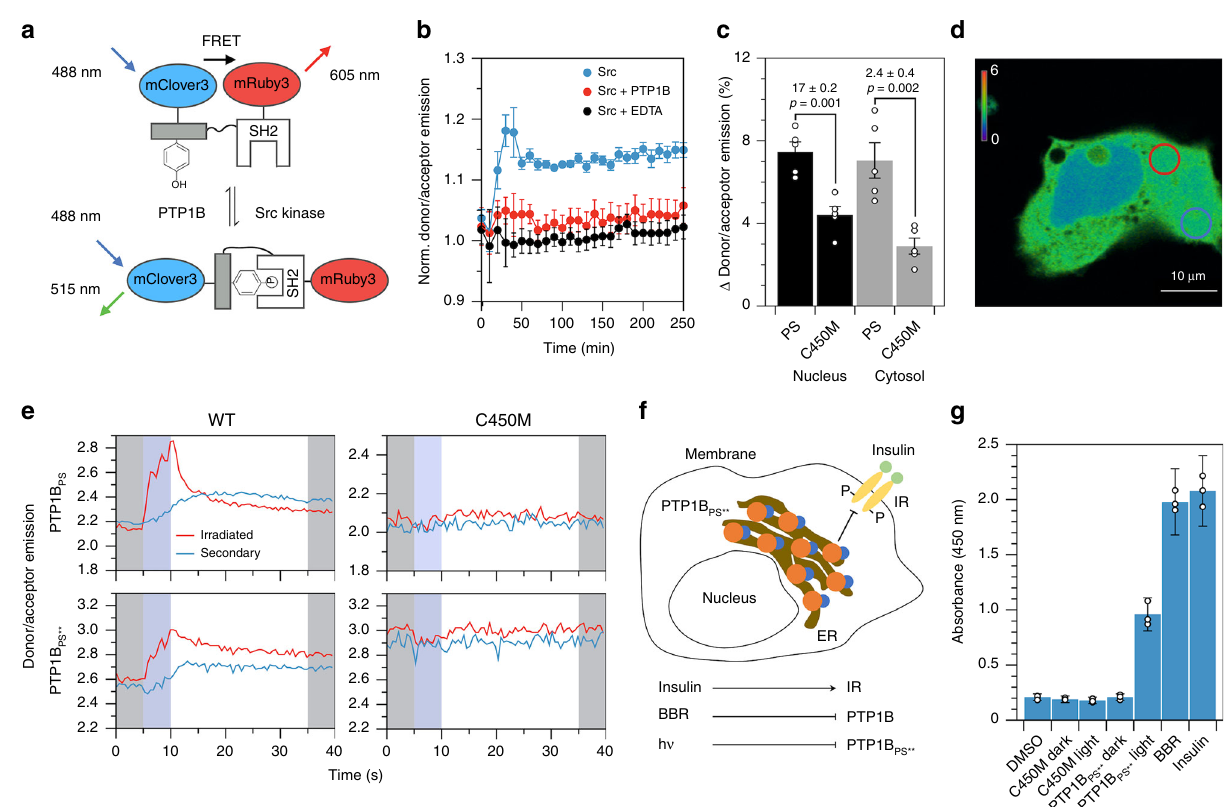
Fig. 4 Localized deactivation of PTP1B PS . a A biosensor for PTP1B activity. Src-mediated phosphorylation of the substrate domain causes it to bind to the SH2 domain, triggering a conformational change that decreases FRET; dephosphorylation by PTP1B increases FRET. b Src increases the donor/acceptor emission ratio in vitro (normalized by the buffer-only condition); EDTA or PTP1B prevent this increase. Error bars denote propagated SE for measurements of n = 3 independent experiments (measurements are normalized to a to a buffer-only condition). c The percent change in donor/acceptor emission ratio over 1 min within 5- μ m circular regions located in the cytosol and nucleus of COS-7 cells activated with 457 nm light. Each condition includes the interquartile average, associated data points, and SE for n = 11 biological replicates. The p -values correspond to a two-tailed Student ’ s t test. d An image of localized illumination (405 nm) of a COS-7 cell expressing both PTP1B PS and biosensor. Circles delineate irradiated (red) and secondary (blue) regions, and colors show the donor/acceptor emission ratio (scale bar, 10 μ m). e Time courses of FRET in irradiated and secondary regions. Shading highlights 5-s periods before (gray), during (blue), and after (gray) illumination. f A depiction of a HEK293T/17 cell expressing PTP1B PS** . Insulin stimulates phosphorylation of the membrane-bound insulin receptor (IR); PTP1B dephosphorylates it. g ELISA-based measurements of IR phosphorylation in (i) wild- type HEK293T/17 cells and (ii) HEK293T/17 cells stably expressing PTP1B PS** or PTP1B PS** (C450M). Insulin-mediated simulation of IR, BBR-mediated inhibition of PTP1B, and photoinactivation of PTP1B all increase IR phosphorylation. The dark state of PTP1B PS** and the dark and light states of PTP1B PS** (C450M), by contrast, leave IR phosphorylation unaltered from its levels in the wild-type strain (DMSO). The plotted data depict the mean, propagated SE, and associated data points for measurements of n = 3 biological replicates (relative to a buffer-only condition). Source data are provided as a Source Data fi